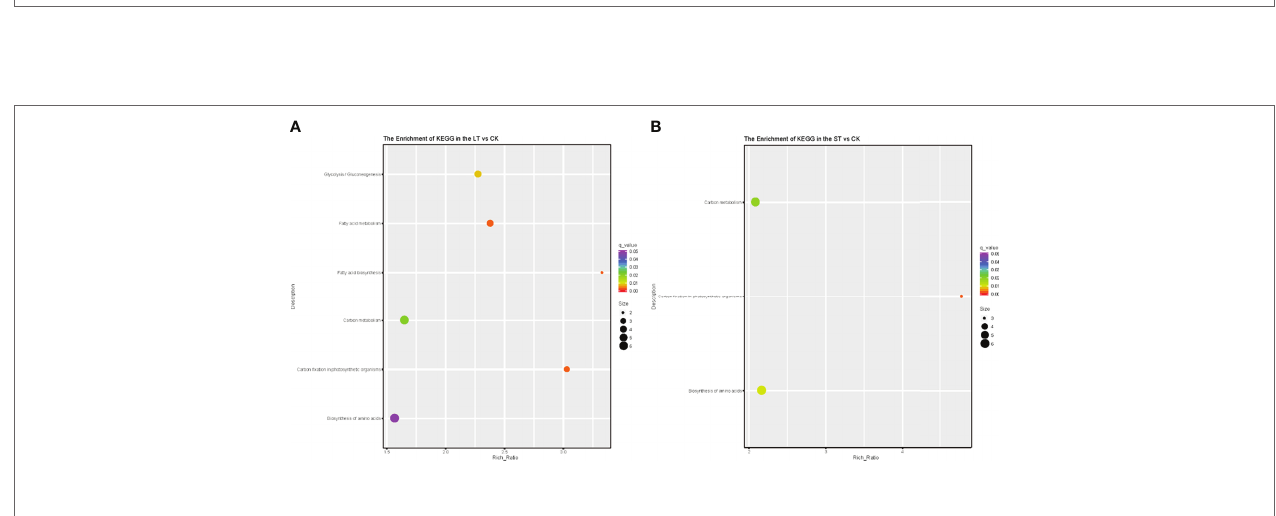
FIGURE 4 | Gene Ontology (GO) functional classification of differentially expressed genes (DEGs). (A) GO functional classification of DEGs in the LT vs CK. (B) GO functional classification of DEGs in the ST vs CK. CK, control; ST, short-term acidification; LT, long-term